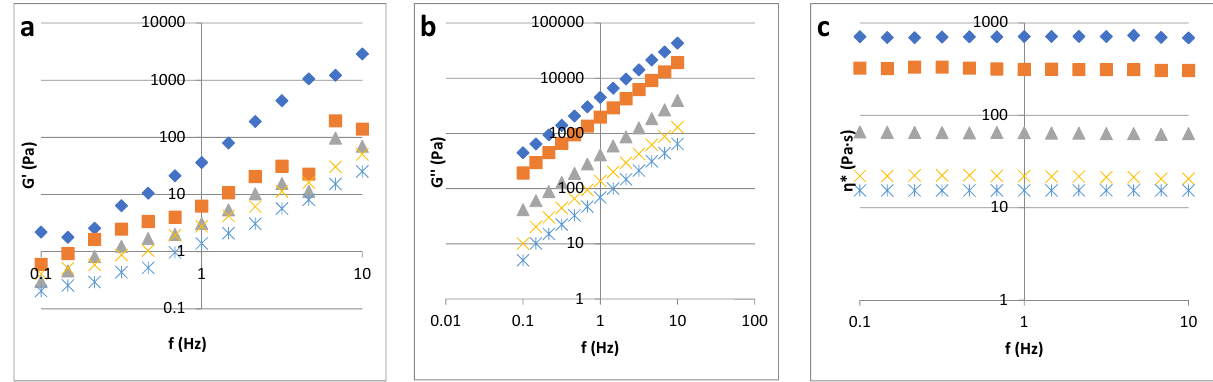
Figure 1. Acacia honey viscoelastical parameter evolution in function of temperature: ( a ) elastic modulus, ( b ) loss modulus, ( c ) complex viscosity: rhombus—5 °C, square—10 °C, triangle—20 °C, cross—30 °C, sign of multiplication—40 °C.